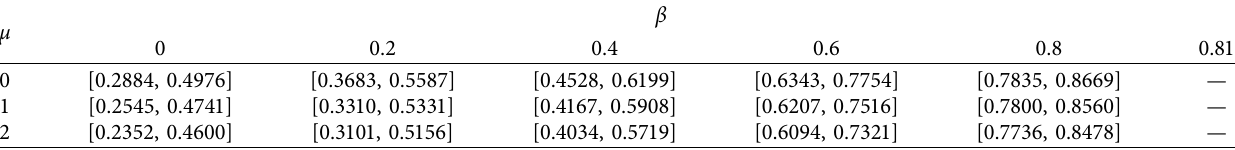
Table 2: The effect of the cognitive biases on the feasible domain of promotion cost-sharing portion ϕ .